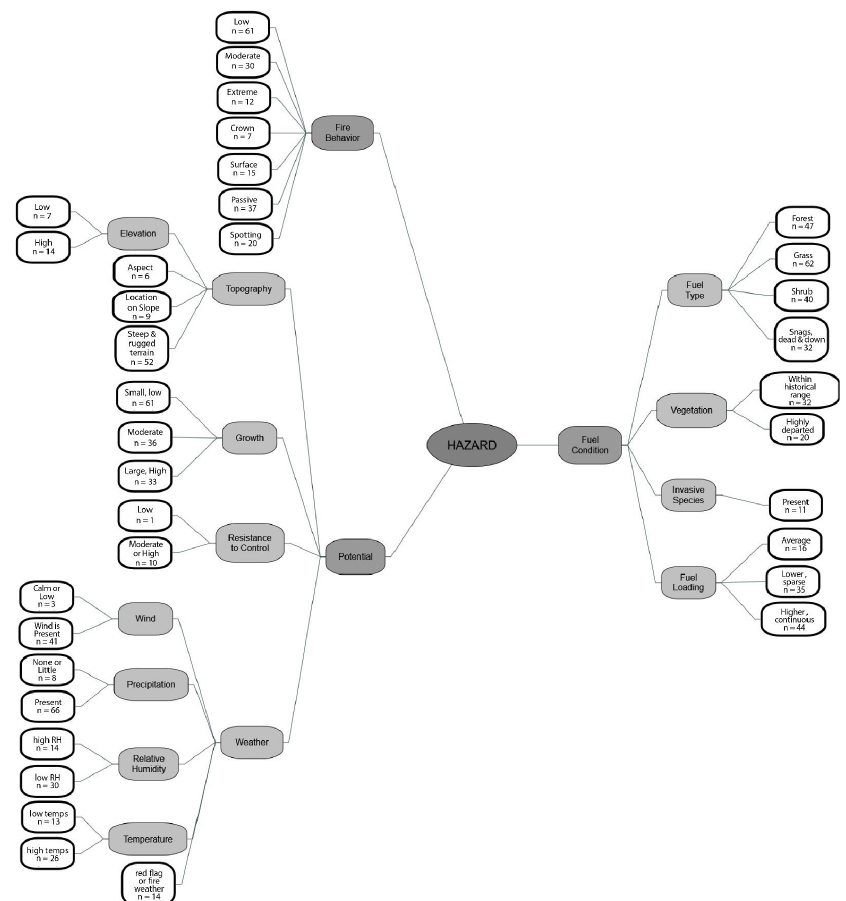
Figure A1. The Hazard Element is summarized by themes (Potential, Fuel Condition and Fire Behavior). The themes are further described by second and third-order sub-themes (light grey shapes), used to summarize types of codes, with the total number of wildfires associated with a specific code, denoted with white shapes.